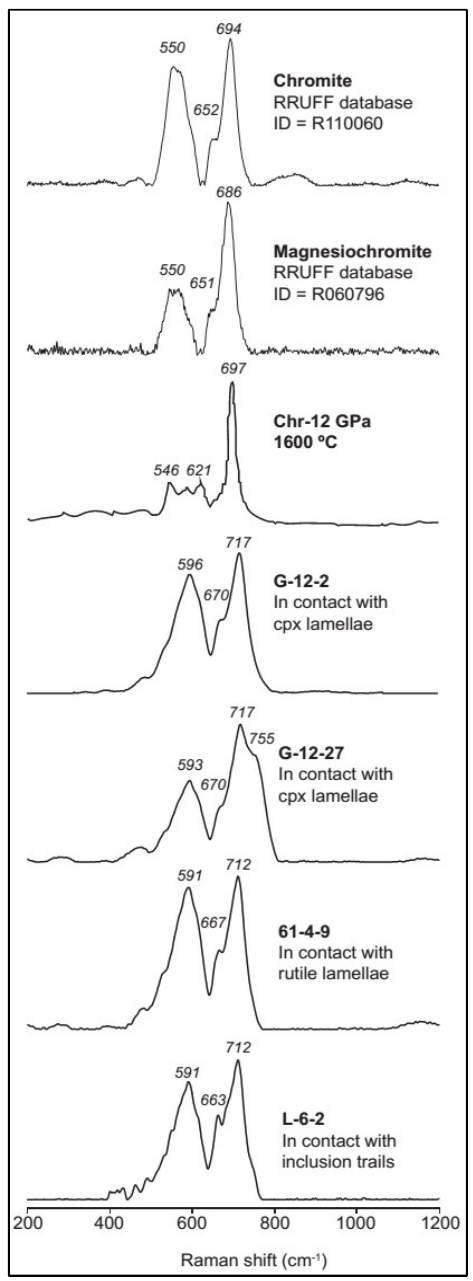
Figure 9. Raman spectra of chromite in the Mercedita chromitites. Spectra of chromite and magnesiochromite from natural examples and experimental works are shown by comparison. The spectrum for high‐pressure chromite polymorph (Chr‐12 GPa, 1600 °C) is from [67].